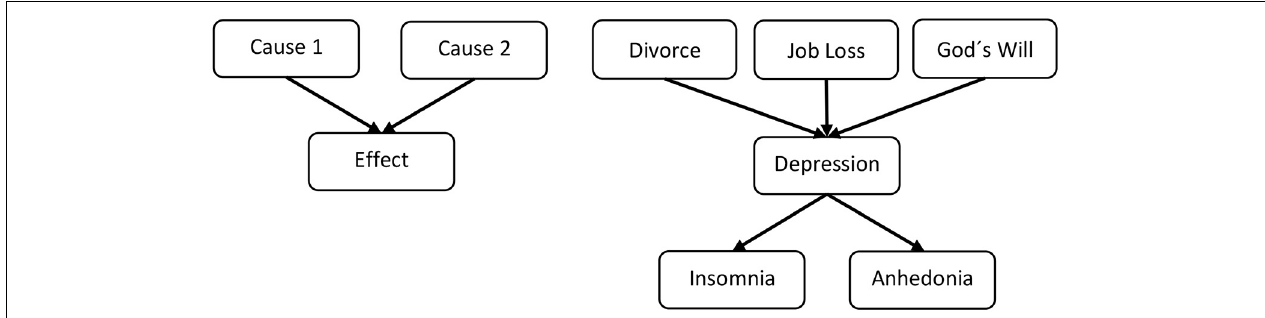
FIGURE 1 | Graphical causal models representing causal relations. On the left hand side an abstract, generic model is depicted, on the right hand side an example for a simplified causal model of depression is presented. Nodes represent variables (events, states) and arrows represent directed causal relations.